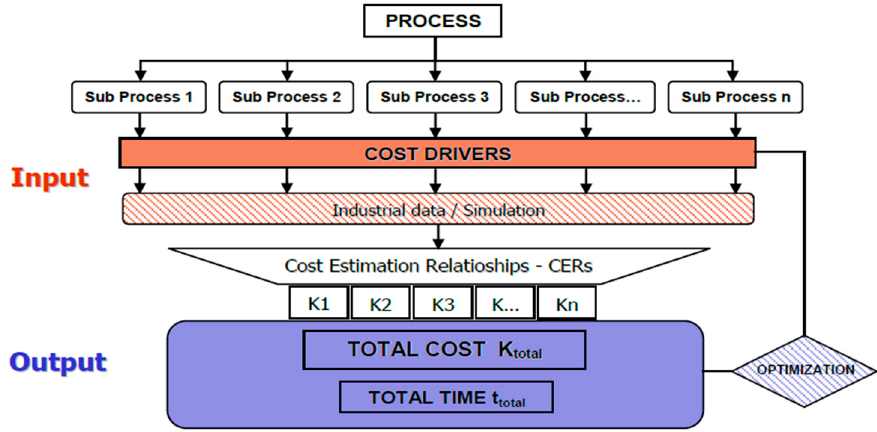
Figure 2. Activity Based Concept (ABC) concept loop [35].